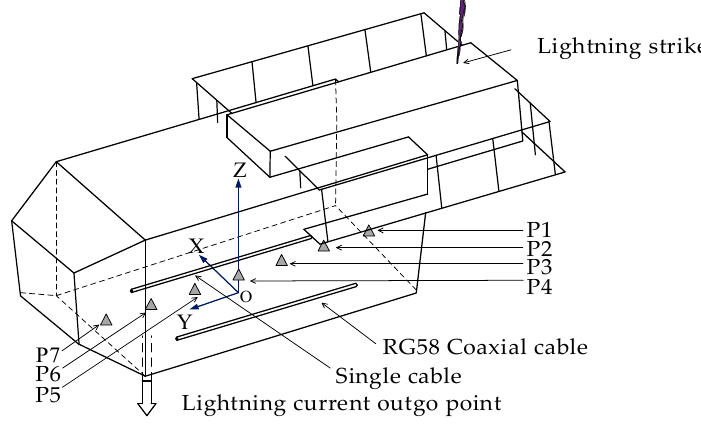
Figure 1. Model of wind turbine nacelle.